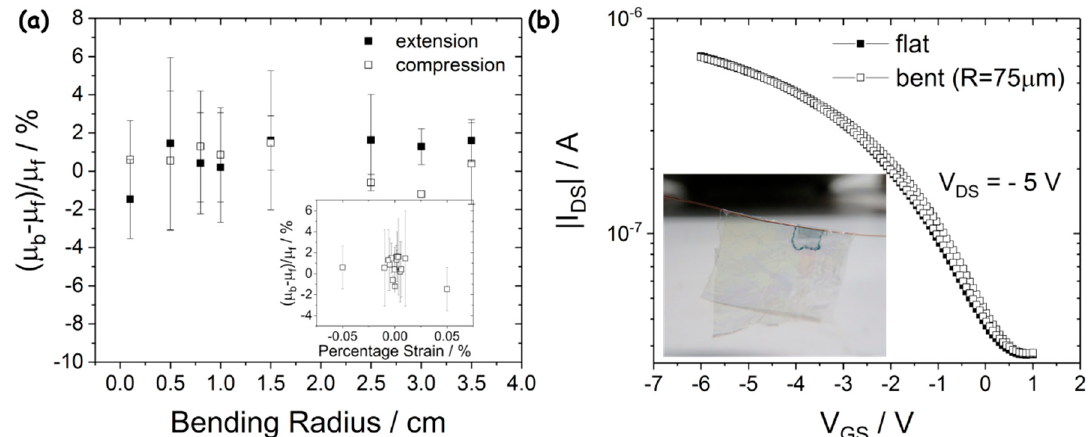
Figure 4. ( a ) Percentage charge carrier mobility variation as a function of mechanical deformations at different bending radii (R = 3.5, 3, 2.5, 1.5, 1, 0.8, 0.5, 0.1 cm) in extension (solid squares) and compression (open squares). In the inset, the corresponding surface strain is shown (extension for positive values, compression for negative values). ( b ) Transfer characteristic curves of an ultra-conformable OFET in flat conditions (solid squares) and while bent over a copper wire with a diameter of 100 µ m (open squares, see picture in the inset).